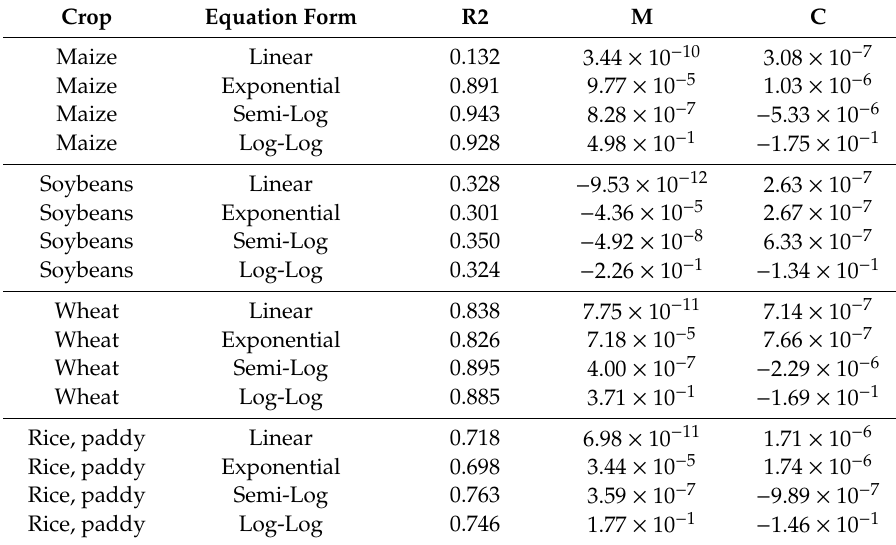
Figure 3. Crop production (including food and feed demands) per capita versus GDP per capita in China. Data: FAO [6]. Table 3. Correlations per crop for China.